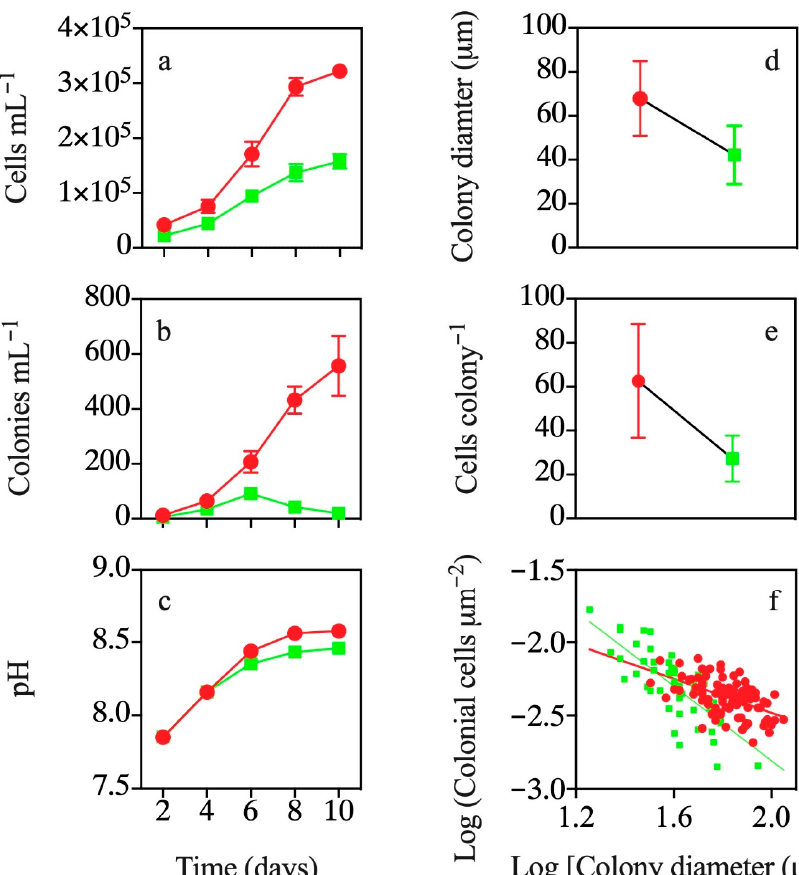
Figure 1. ( a ) The solitary cell abundances (Mean ± SD, n = 3), ( b ) the number of colonies (Mean ± SD, n = 3), ( c ) pH (Mean ± SD, n = 3), ( d ) colony diameters (Mean ± SD, n = 90 and 58 for control and treatment, respectively), ( e ) the number of cells per colony (Mean ± SD, n = 90 and 58 for control and treatment, respectively) and ( f ) linear relationship between Log (colonial cells µm − 2 ) and Log [colony diameter (µm)] (n = 90 and 58 for control and treatment, respectively) in P. globosa grown alone (red circles) and co-cultured with T. weissflogii (green squares).